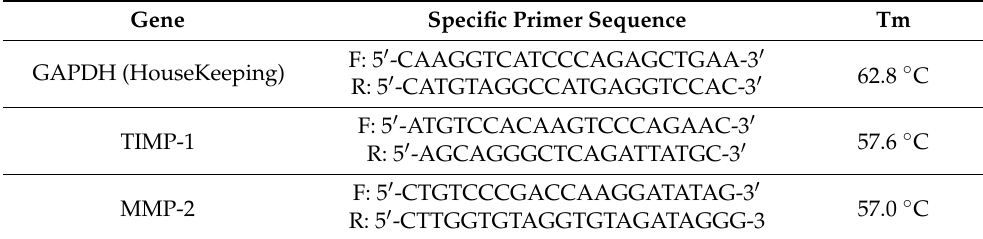
GAPDH: Glucose 6 Phosphate Dehydrogenase, TIMP-1: Metallopeptidase Inhibitor 1, MMP-2: Matrix metalloproteinase-2, Tm: melting